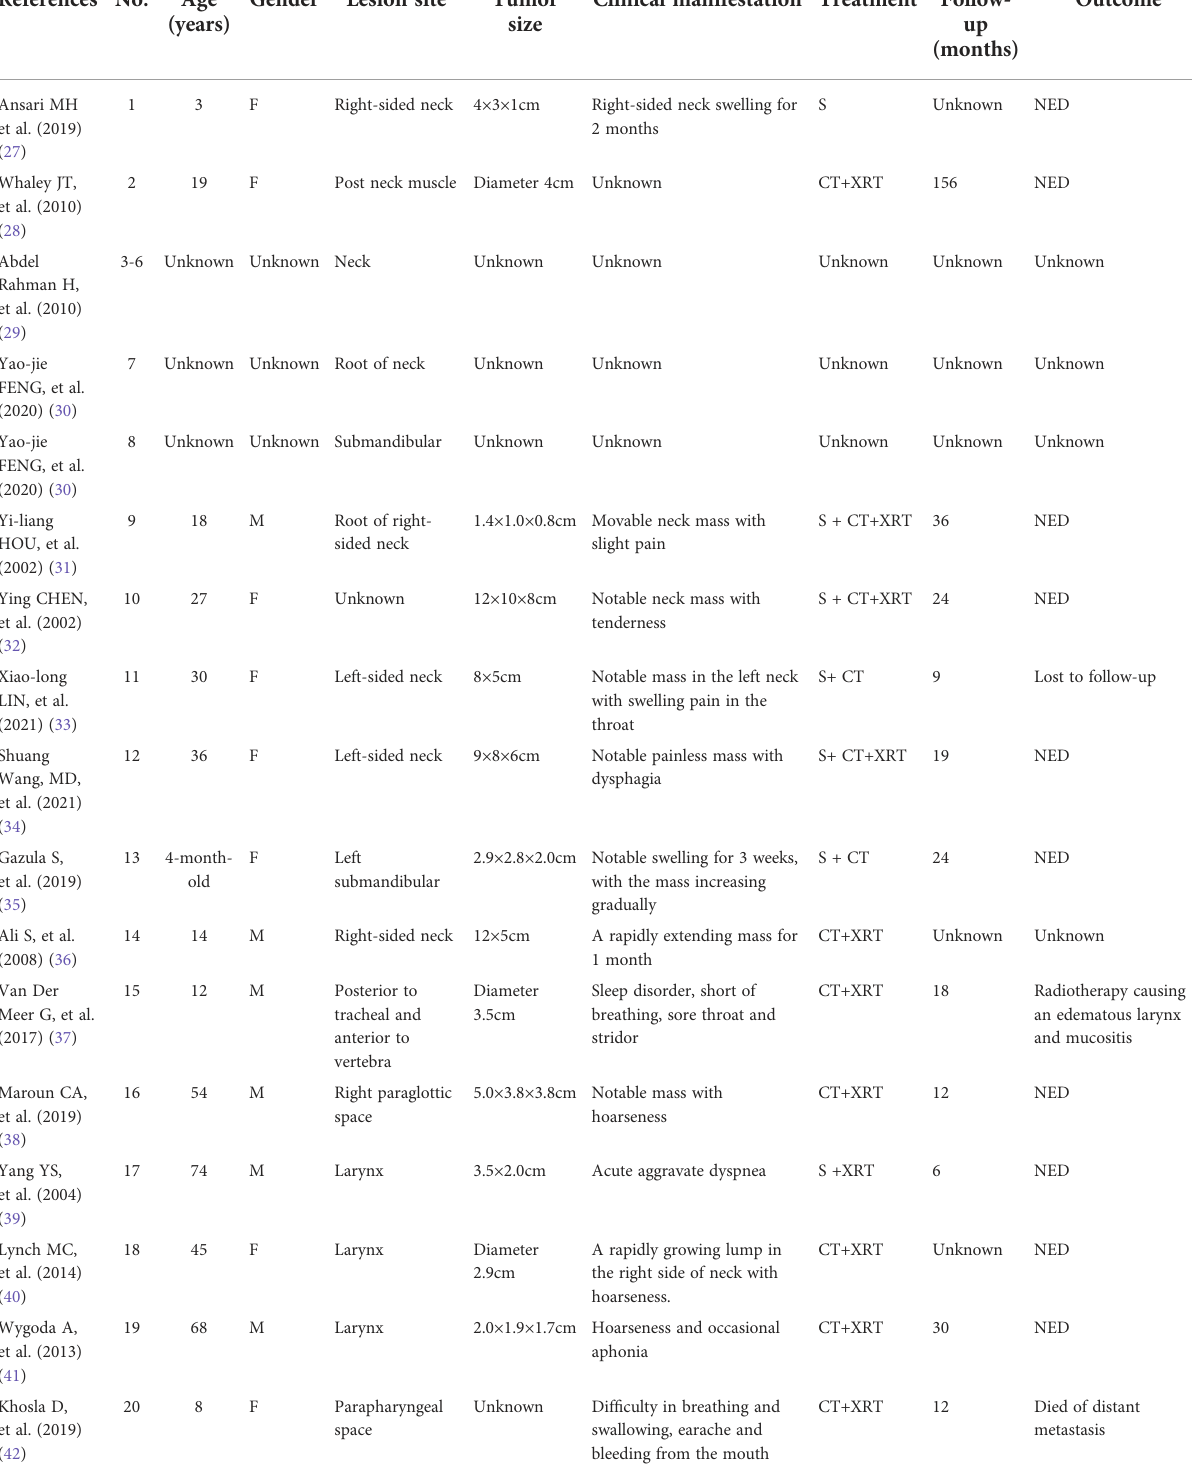
TABLE 1 Summary of previous published articles on cervical